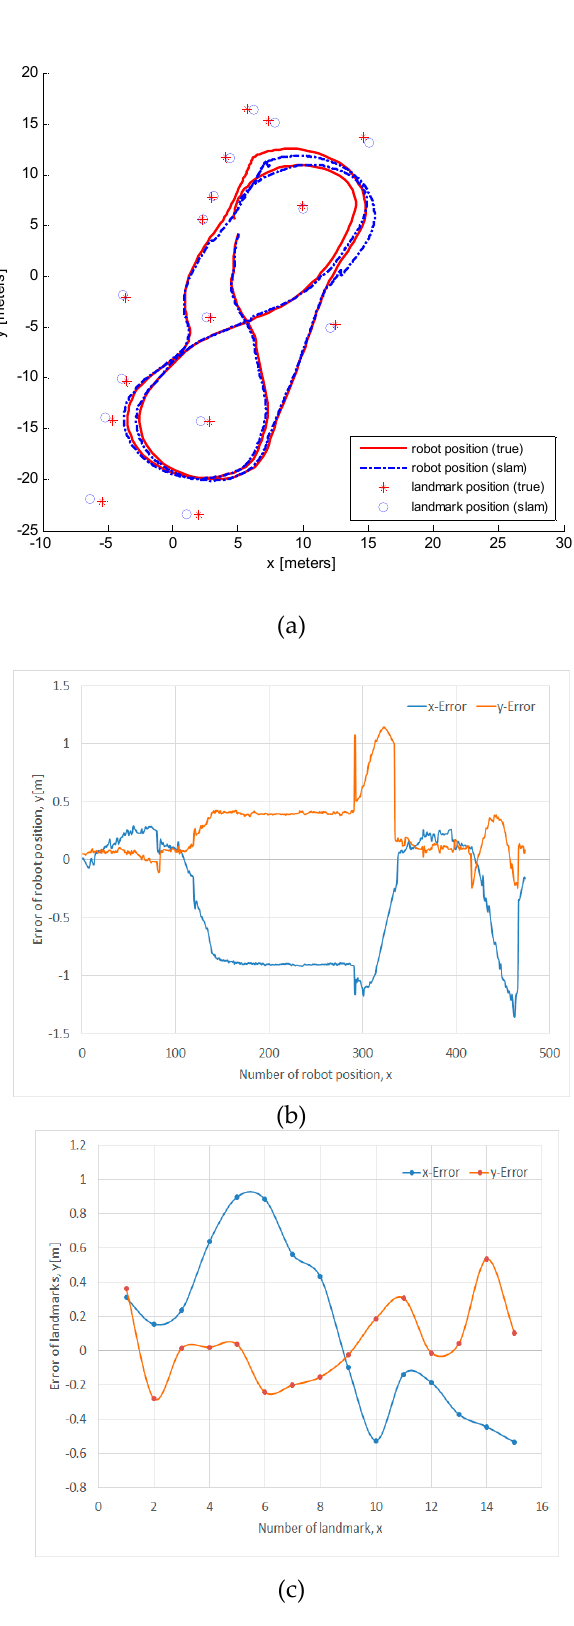
Figure 11. Simulation results for SLAM with an SNR of 50(dB) in the distance data: ( a ) EKF-SLAM for the mobile robot based on microphone landmark observations; ( b ) robot position errors in the x - and y -directions; and ( c ) landmark position errors in the x - and y -directions.